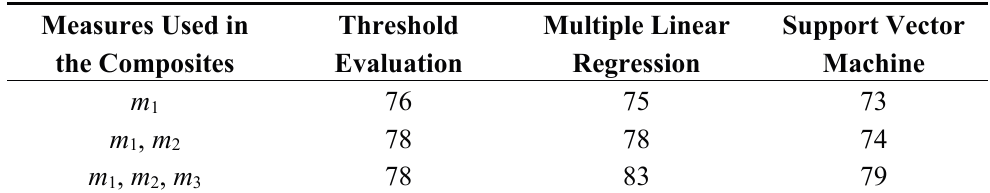
Table 8. Percentage of correctly classified map samples for each composite method using the measures m 1 = object line length, m 2 = number of object types and m 3 = proximity